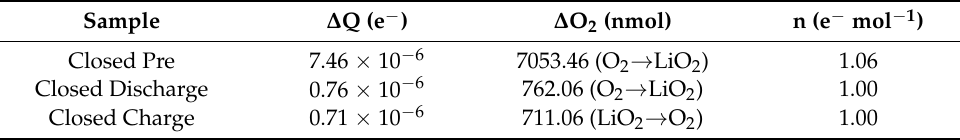
Figure 5. DEMS analyses in Pd–rGO closed battery. The amount of O 2 consumed and released in different processes: ( a ) pre–discharge; ( b ) closed–discharge; ( c ) closed–charge; ( d – f ) is the corre– sponding gas and capacitance curve. Table 3. DEMS data of a Pd-rGO closed battery. Table 3. DEMS data of a Pd-rGO closed